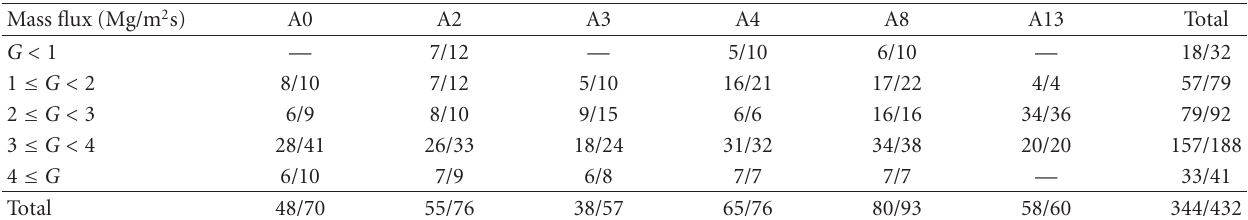
Table 10: Number of cases where ASSERT steady state DNB predictions fell within ± 10% of measured value, arranged by mass flux. Mass flux (Mg/m 2 s)